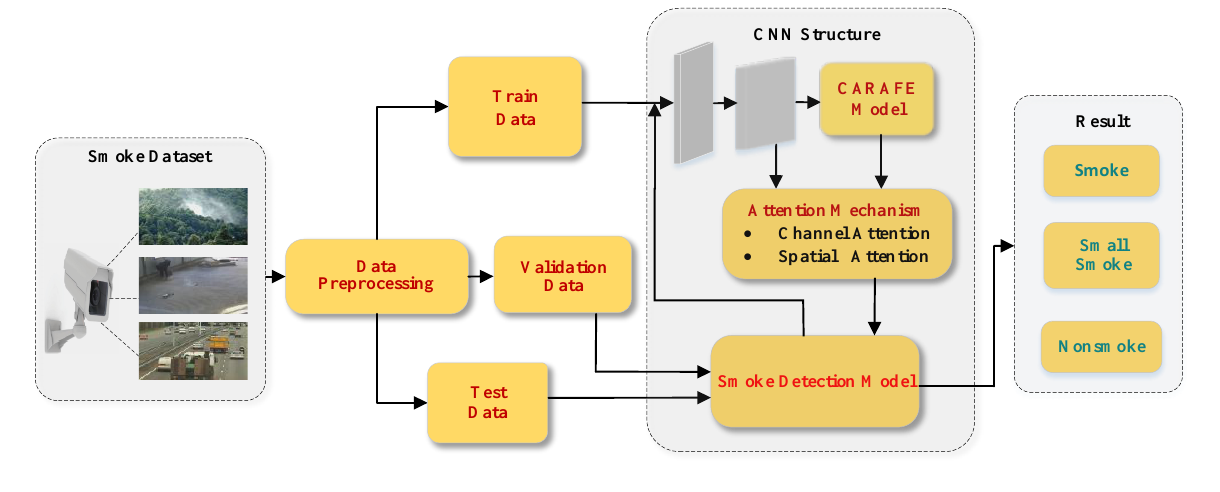
Figure 1. Overall framework.